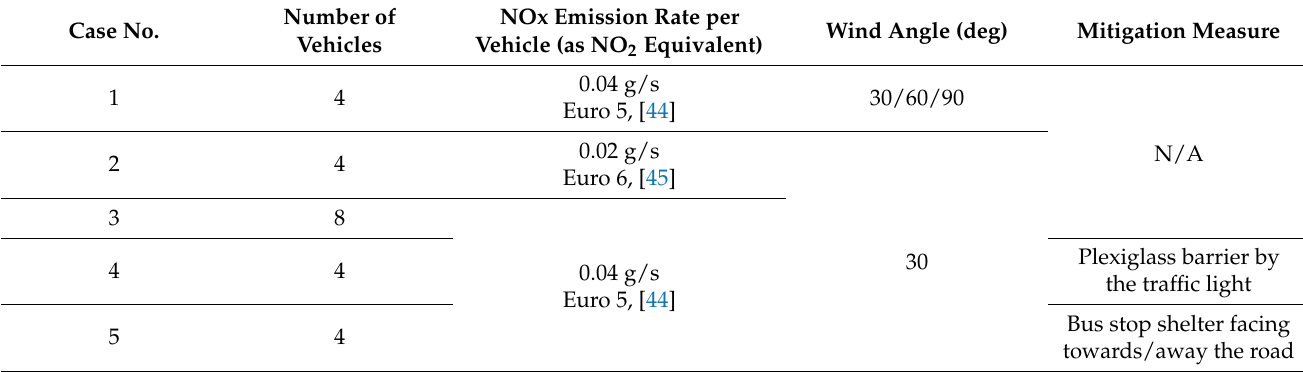
Table 1. Details of the different case studies.